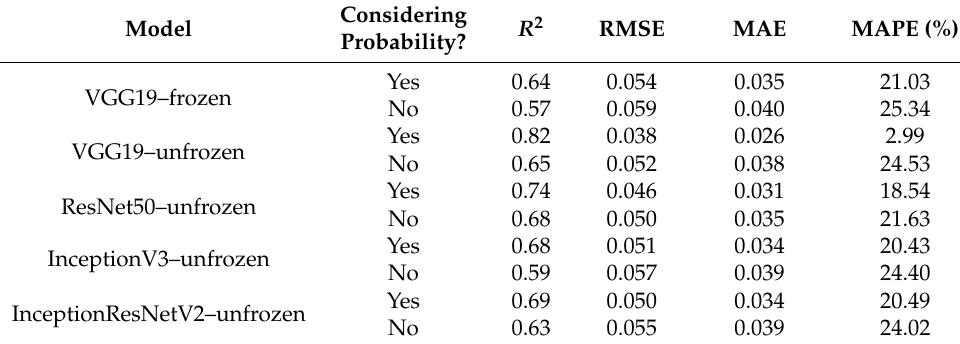
Table 3. Analysis of